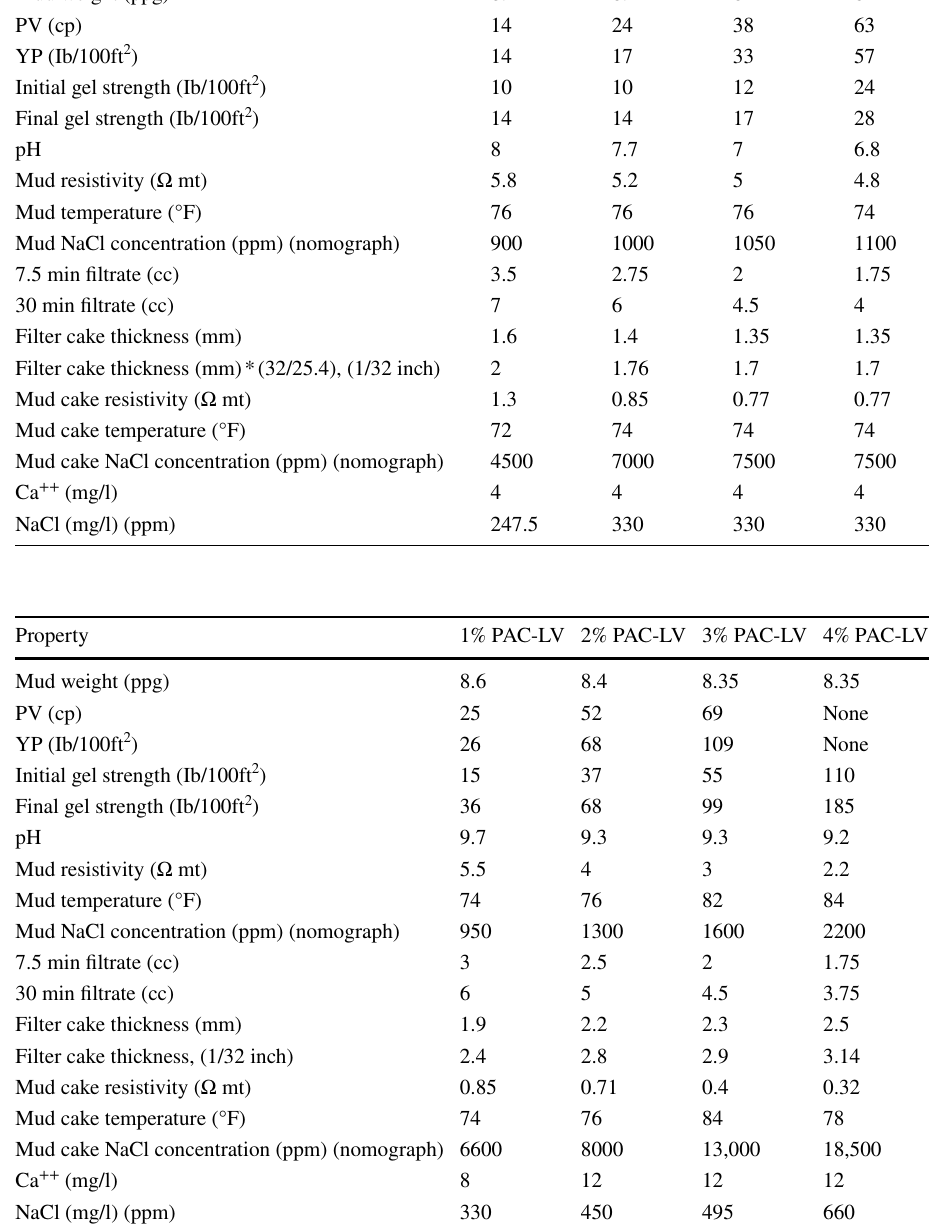
Table 2 The results of adding various concentrations of MPP on the properties of reference fluid